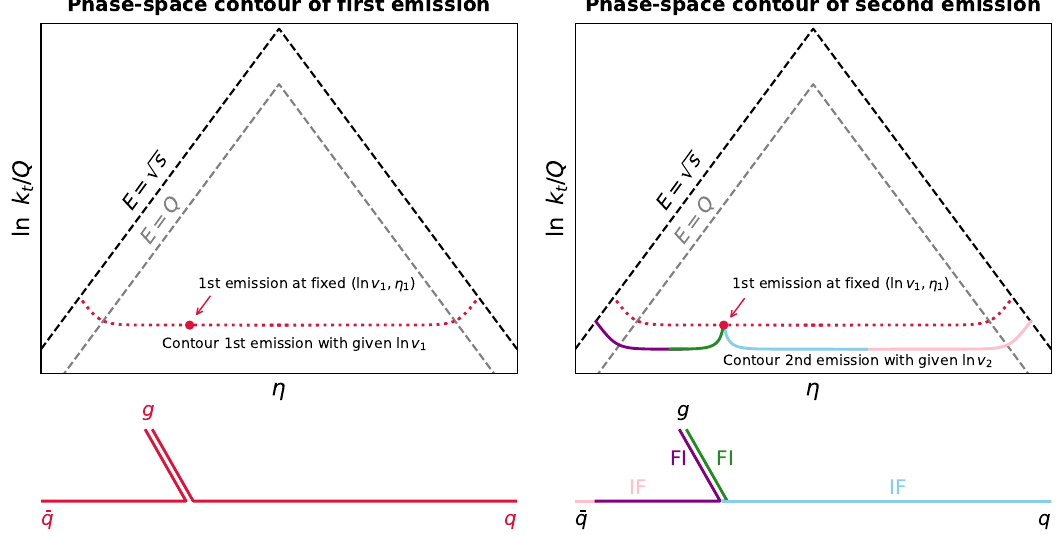
Figure 1. Illustration of the hadron-collider primary Lund plane, where the rapidity and transverse-momentum coordinates are defined with respect to the hadron beam directions. The left-hand plot shows the contour for the first emission from a Dipole- k of the ordering variable (local and global are identical here). The red point indicates the specific value of η that is used in subsequent plots when adding a second emission. The right-hand plot 1 additionally shows the contour for such a second emission at a fixed value of v is colour-coded to roughly represent the partitioning of the two dipoles into IF and FI regions, as illustrated also below the plot. Note that the momentum of the second emission is shown as projected onto the primary Lund plane, to avoid having to represent the 3-dimensional secondary Lund plane. See text for further